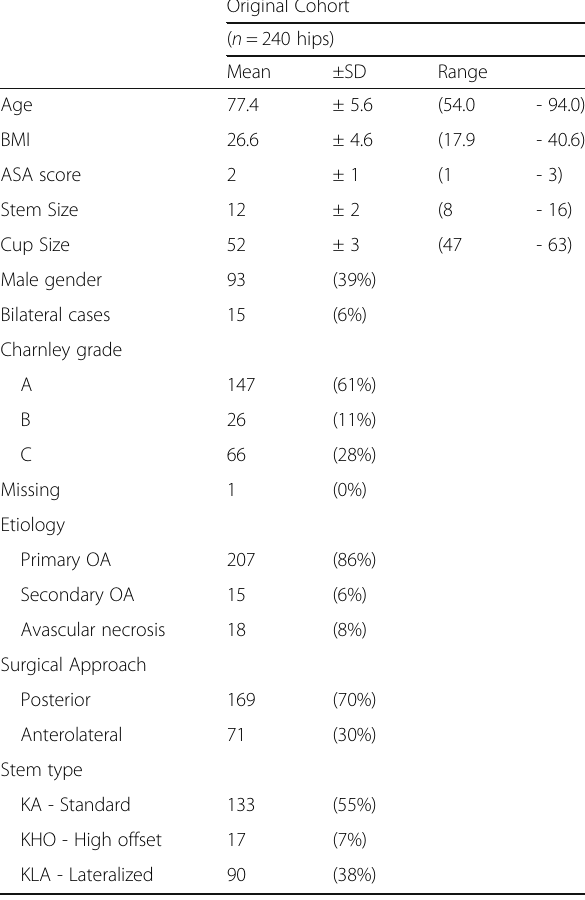
Table 1 Preoperative demographics, and morphological data Original